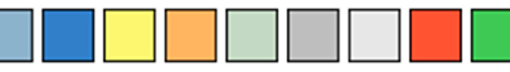
Figure 14. The Wikimapia color scheme.